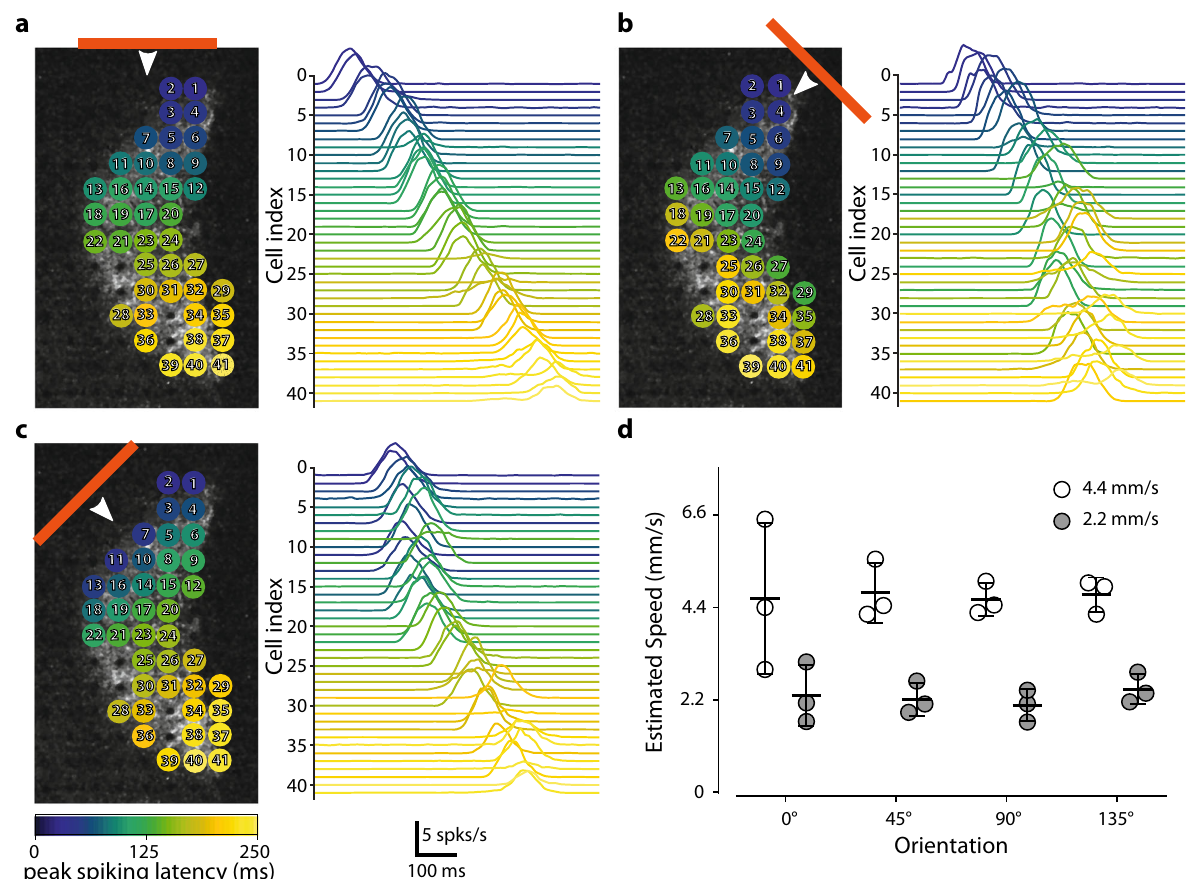
Fig. 6 The measured activity is suf fi cient for estimation of the speed and direction of a moving bar. a Various responses of the individual cells to a horizontal bar moving (75- µ m long represented by the horizontal orange line moving at 2.2 mm/s downwards as indicated by the white arrow) across a transfected retina. The various cells recorded are represented in the panel on the left. The colors indicate the times at which peak spiking activity occurred for each cell relative to the earliest cell activation peak for the motion of the bar. The right panel shows the mean fi ring plots for all the recorded cells. The cells are ordered according to peak spiking latency. b , c As in a but with other two moving bar directions (45° for b and 135° for c ). The cell index was retained. d A simple plane fi tting-based method predicted the relative speed of the bars presented at either 2.2 mm/s or 4.4 mm/s ( n =